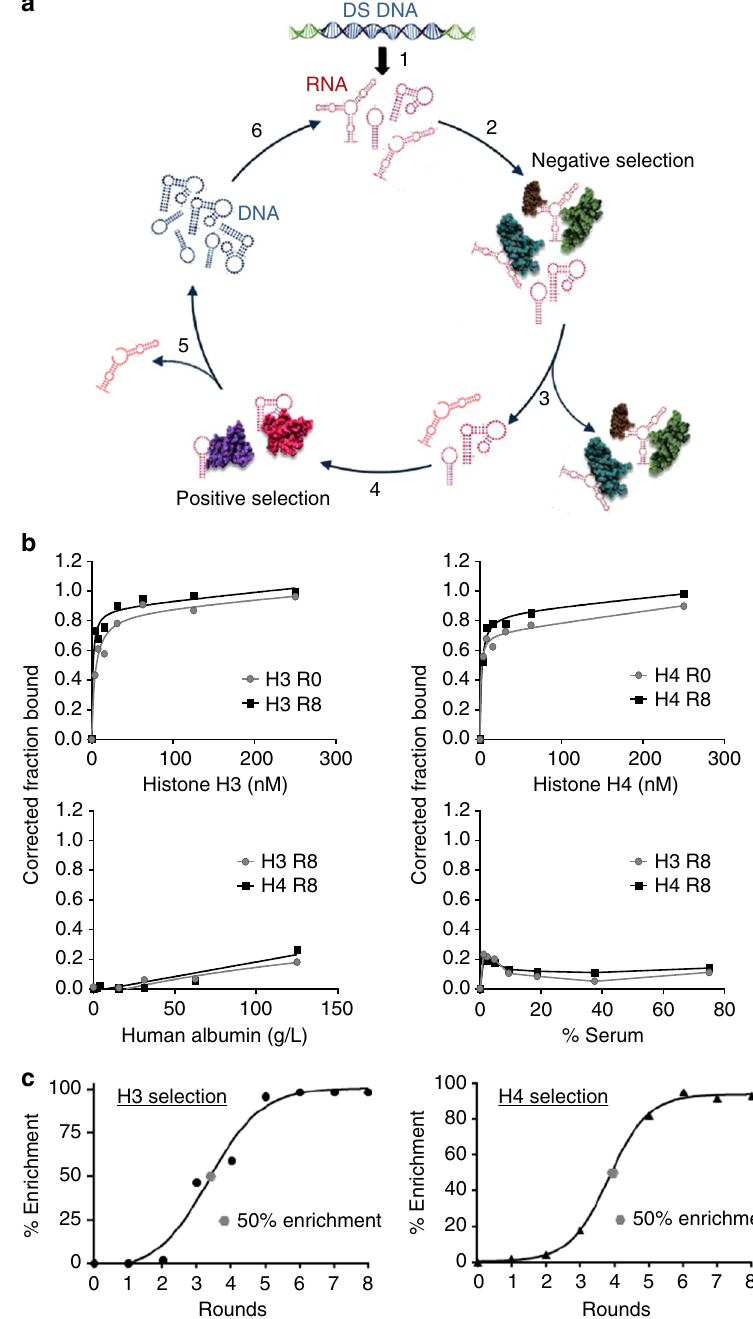
Fig. 1 Identi fi cation of histone-speci fi c RNA aptamers using SELEX. a Schematic of the in vitro Systematic Evolution of Ligands by Exponential Enrichment (SELEX) procedure. Step 1. Double-stranded DNA (DS DNA) template library (Sel2N20) is in vitro transcribed in the presence of 2 ′ Fluoro pyrimidines and 2 ’ OH purines to generate the 2 ′ Fluoro-modi fi ed Round 0 RNA library (RNA). Step 2. The round 0 RNA library was incubated with human albumin